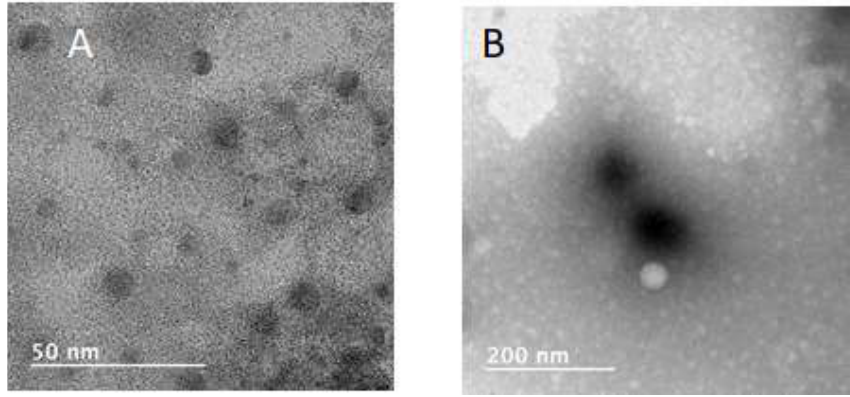
Figure 4. TEM images of ( A ) PdiMeMLA 54 - b -PdiMeMLAHe 29 , and ( B ) PdiMeMLA 27 - b -PdiMeMLAHe 50 based NPs. Table 6. Characteristics of DiR-loaded NPs